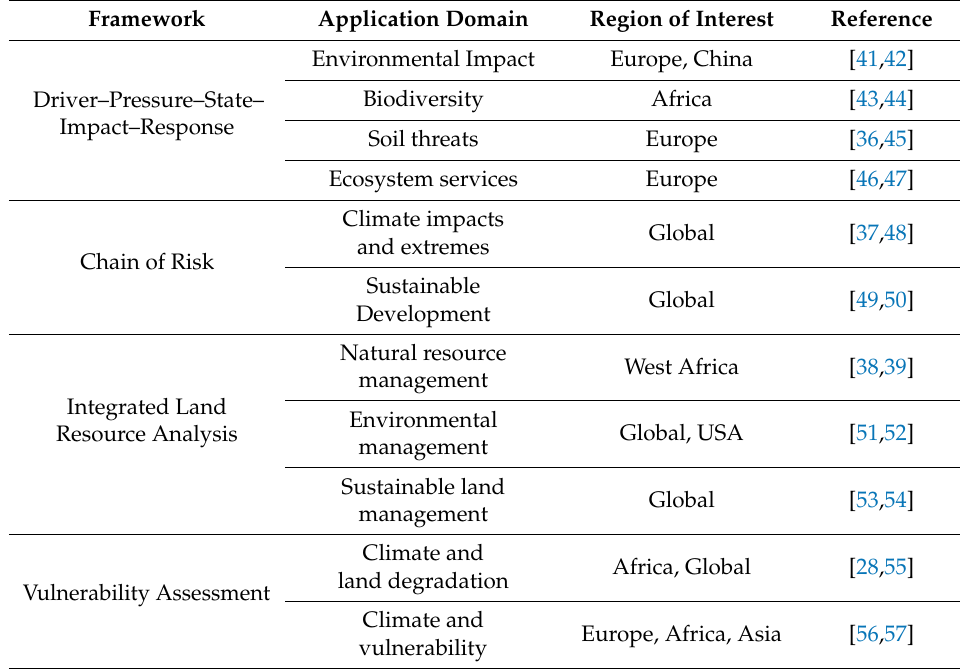
Table 1. Frameworks used in this study and their application domain across the